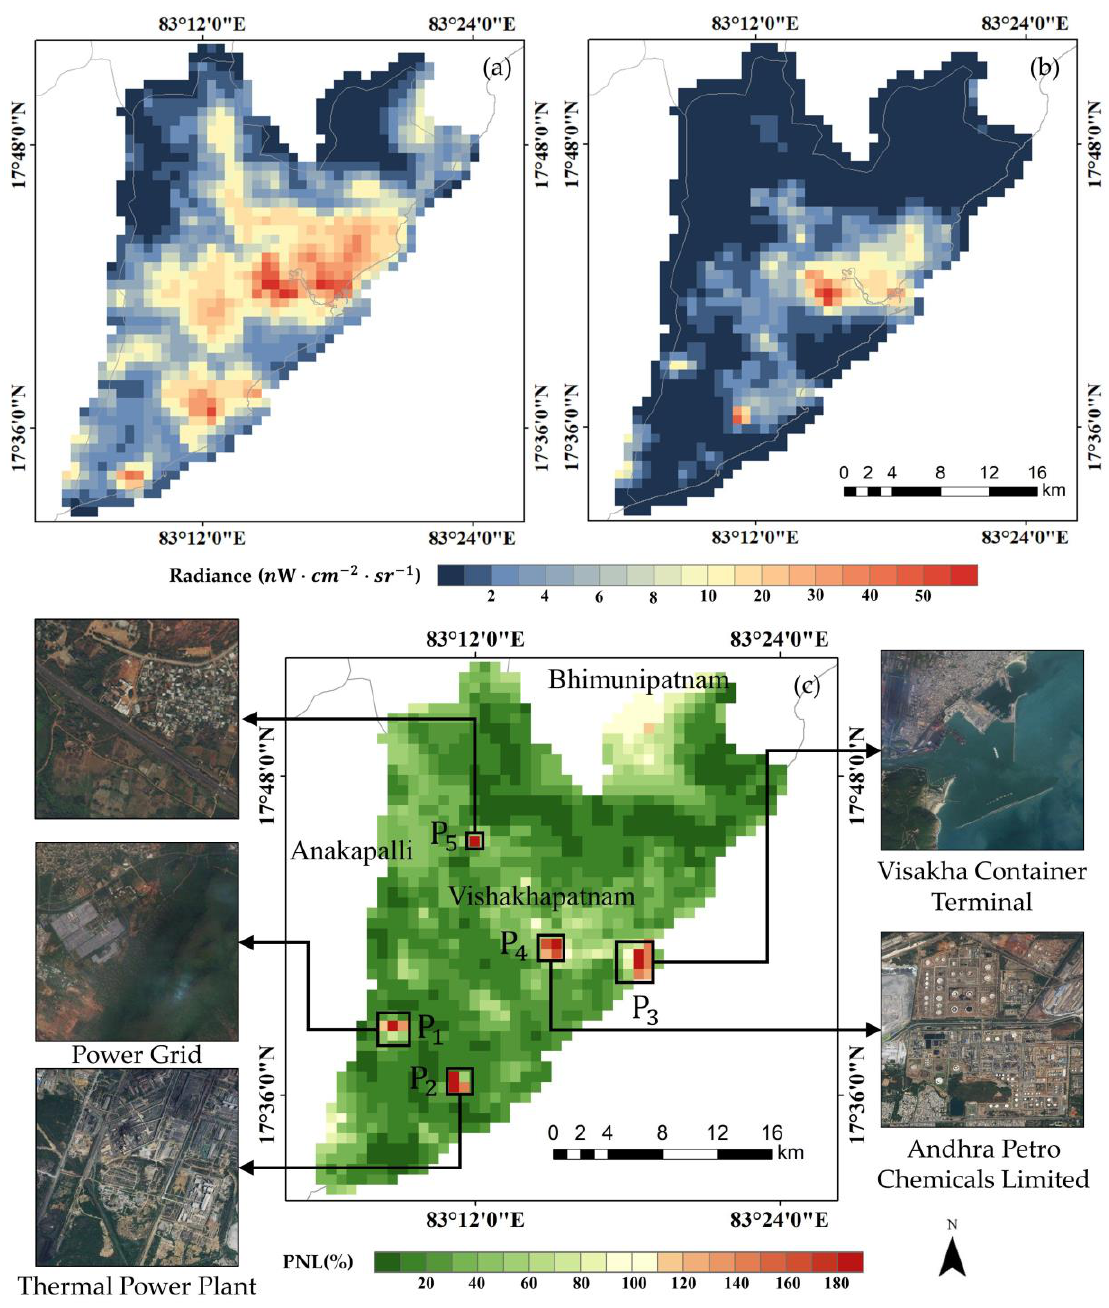
Figure 7. ( a ) The pre- and ( b ) post-storm averaging composite DNB images, ( c ) PNL image and Bing satellite images for the brighter region of Cyclone Hudhud.